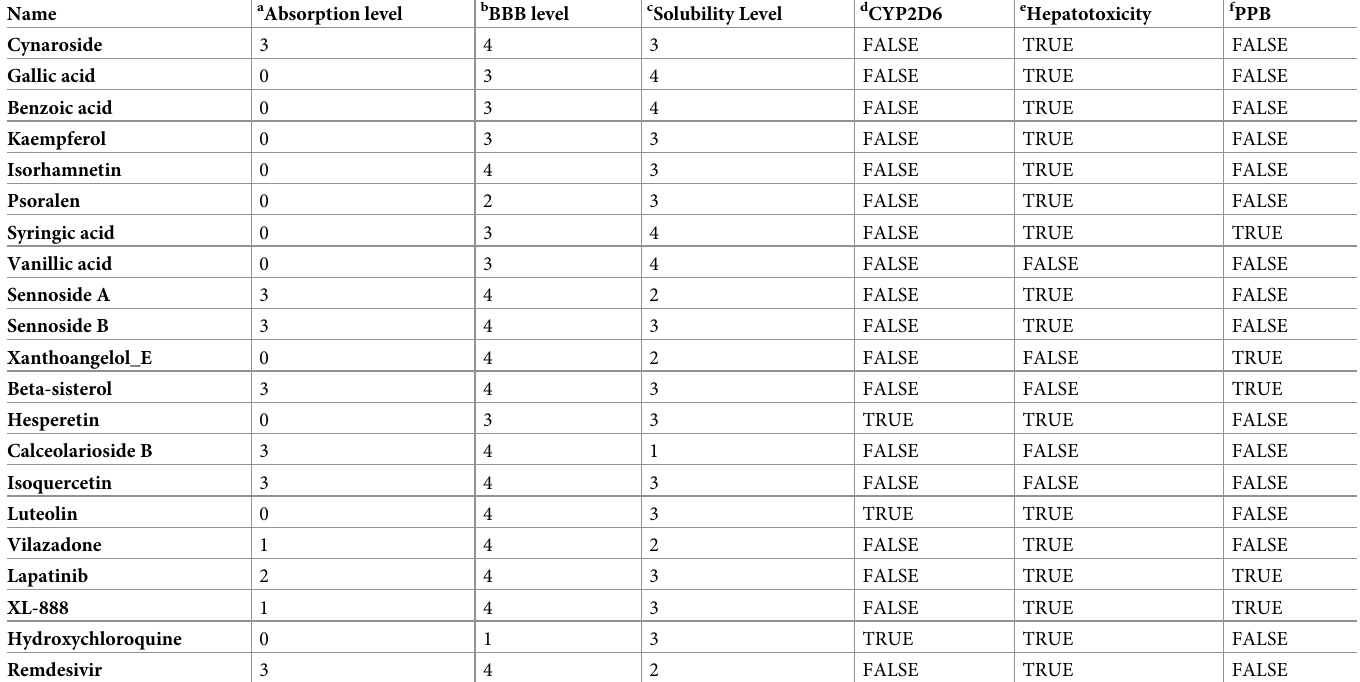
Table 4. ADMET properties of chemical compounds present in Senna in comparison with the active phytochemicals and FDA-approved drugs.